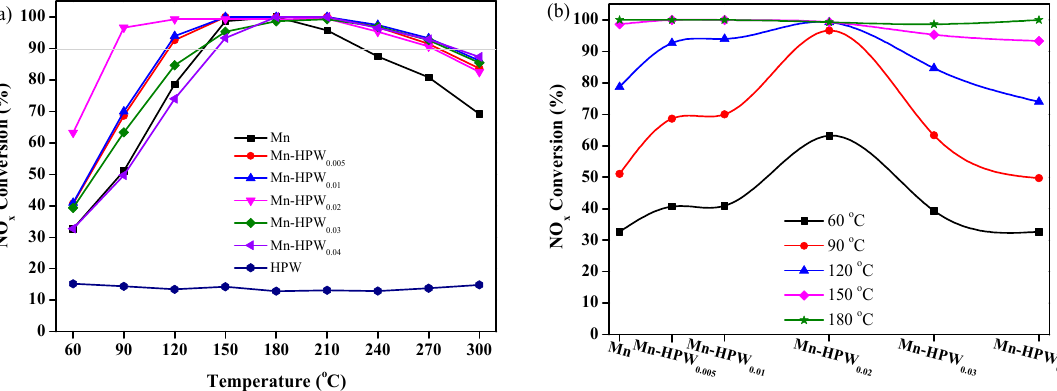
Figure 5. NH 3 -SCR activity on HPW, Mn, and Mn-HPW x at 60–300 ◦ C ( a ) and at 60–180 ◦ C ( b ). The de-NO x activity over the Mn catalyst can be enhanced by the modification with metal oxides, such as NbO x [58], CoO x [30], SmO x [53], FeO x [28], EuO x [59], CuO x [60], NiO x [61], and CeO x [62,63]. Table S1 lists some representative Mn-based catalysts for NH 3 -SCR. For instance, more than 90% NO x can be converted at 125–350 ◦ C on Mn x Co 3-x O 4 nanocages under relatively milder conditions (0.40 g catalyst, (NO) = 500 ppm, flow rate = 210 mL/min) [30]. Above 90% NO x at 125–225 ◦ C can be achieved on (Cu 1.0 Mn 2.0 ) 1- δ O 4 under conditions (0.15 g catalyst, (NO) = 500 ppm, flow rate = 200